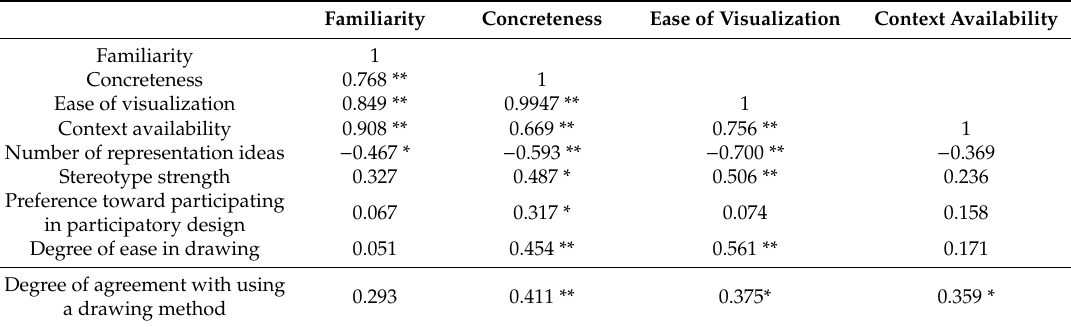
Table 2. Correlation coe ffi cients among message characteristics, number of representation ideas, strength of stereotype, preference toward participating in participatory environmentally friendly message design, degree of ease in drawing intended message representations, and degree of agreement with using a drawing method to illustrate intended message